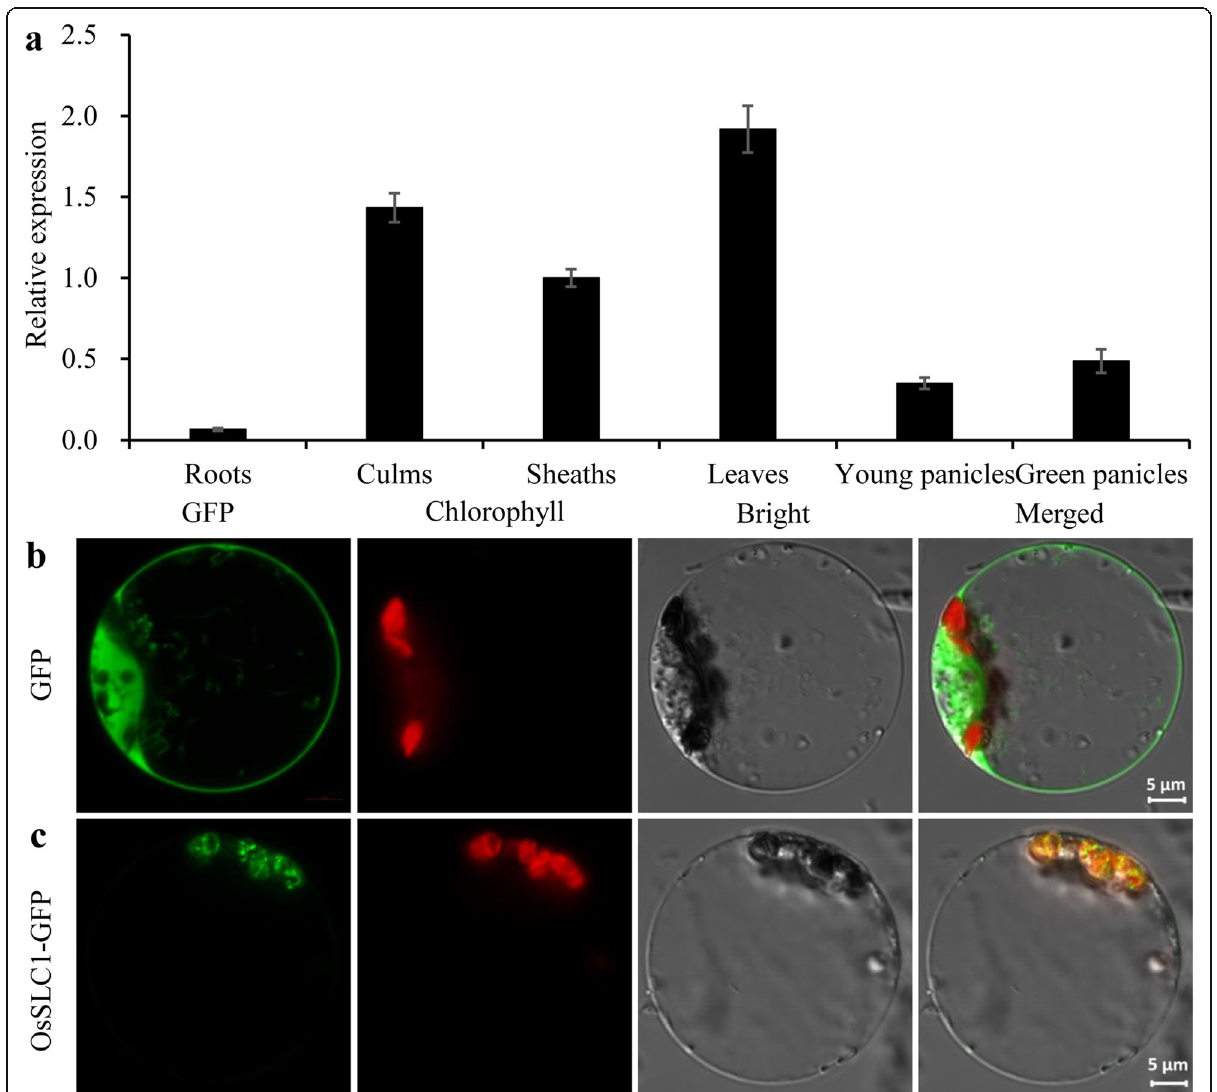
Fig. 4 Expression profile analysis of OsSLC1 in the wild type plant and subcellular localization of OsSLC1 in rice protoplasts. a Expression analysis of OsSLC1 in a variety of wild type tissues. RNAs were extracted from roots, culms, sheaths, leaves, young panicles (white) and green panicles at the heading stage. b Observation of free green fluorescent protein (GFP) signals in rice protoplasts. c Observation of OsSLC1-GFP fluorescent signals in rice protoplasts. Scale bars, 5 μ